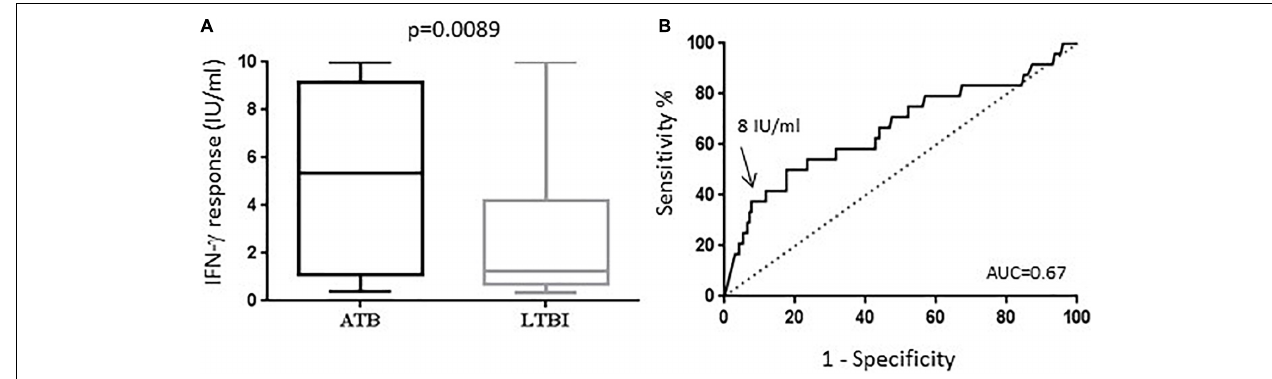
FIGURE 1 | QFT results for discrimination between active and latent tuberculosis. (A) The level of IFN- γ in ESAT-6, CFP-10 simulated T cells was quantified by the QFT assay from blood samples of 24 patients with ATB (black boxplot) and 171 patients with LTBI (gray boxplot). The median, IQR, 10th and 90th is shown in boxplots of each group. The p -value was calculated by the Mann–Whiteny U test. (B) The ROC curve shows sensitivity vs. specificity for IFN- γ in differentiating the ATB from LTBI group. The AUC and a threshold at 8 IU/ml are indicated in the graph.